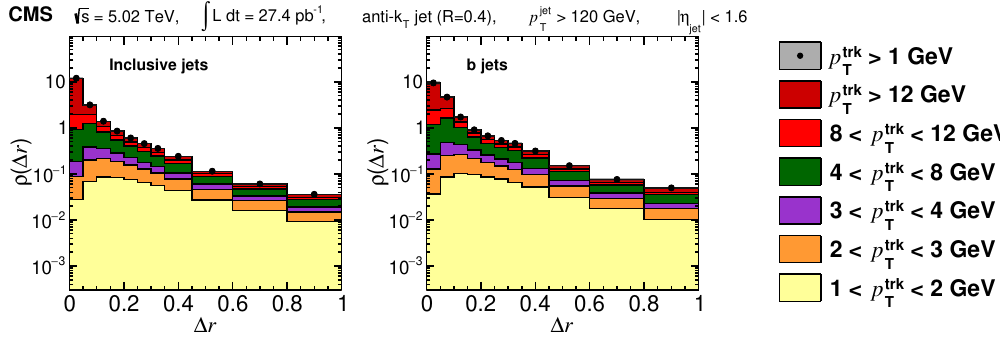
Figure 3 . The jet shape distribution ρ (∆ r ) of inclusive jets (left) and b jets (right) with p 120 GeV as functions of ∆ r are presented differentially for all p trk boxes represent the systematic uncertainties for p trk to be